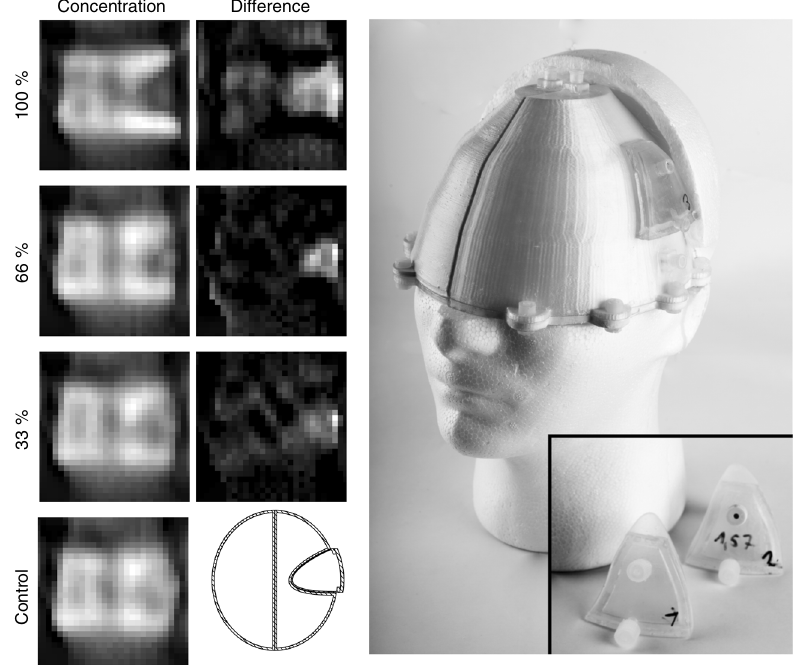
Fig. 5 Results of the static stroke experiment. (left) Reconstruction results. In the control case both hemispheres and the stroke part were fi lled with a identical iron concentration of 965 ng Fe ml − 1 with a total amount of 938.8 µ g Fe . For the other cases the iron concentration in the stroke parts was less, which can be identi fi ed in the images as a lower particle concentration in all three cases. The stroke parts can be seen in the picture next to the head. (center). The lower concentration in the stroke area becomes even more prominent when subtracting the control image from the stroke images as can be seen in the second column of the images. As reference a cut of the CAD model is drawn next to the control image. (right) Photograph of the phantom mounted on a human head